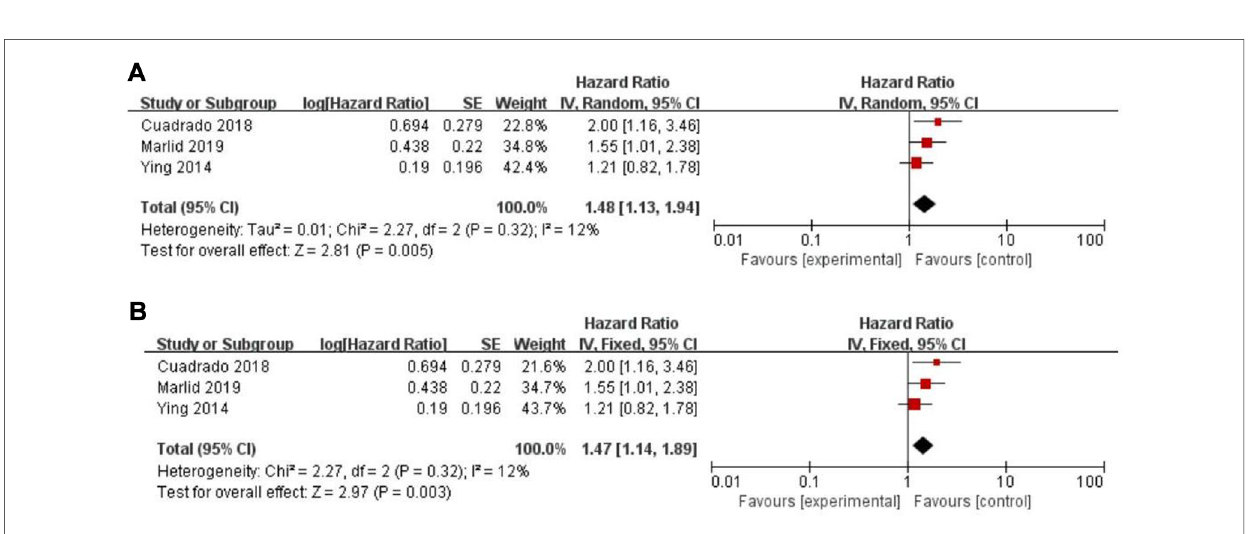
FIGURE 4 Forest graph on association of recurrence-free survival with different levels of platelet-to-lymphocyte ratio groups. ( A ) random effect model. ( B ) fi xed effect